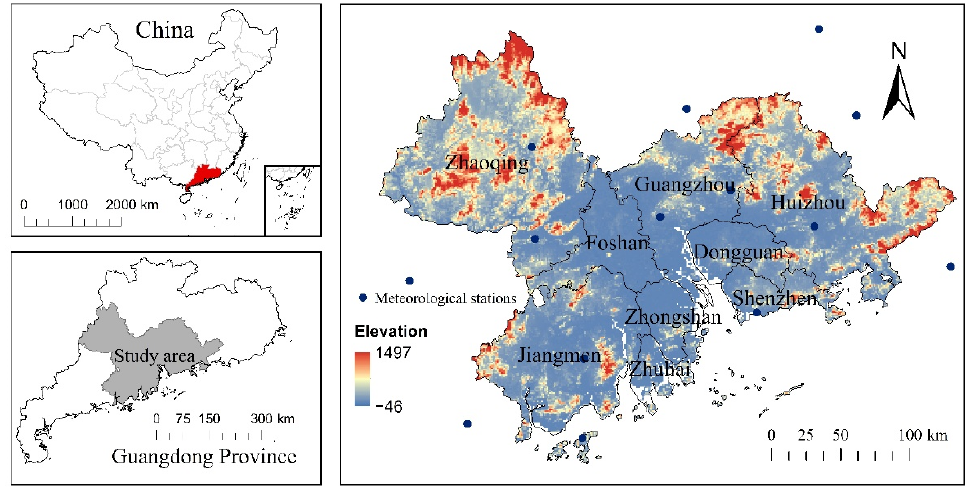
Figure 1. Geographical locations of the Pearl River Delta (PRD) and weather